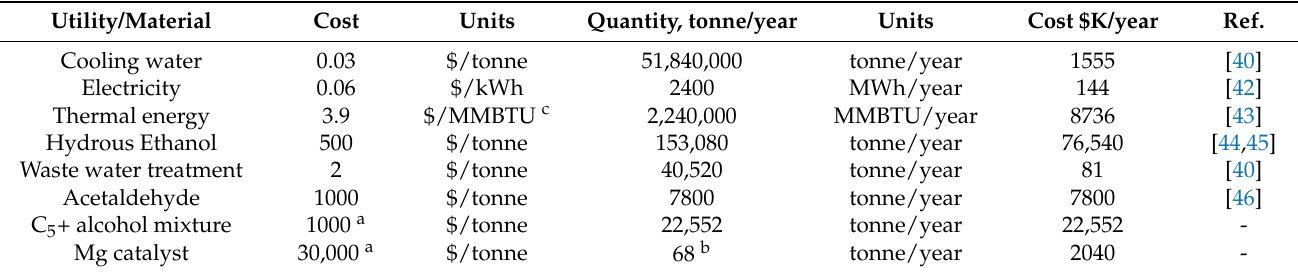
Table 8. Cost of utilities and materials.